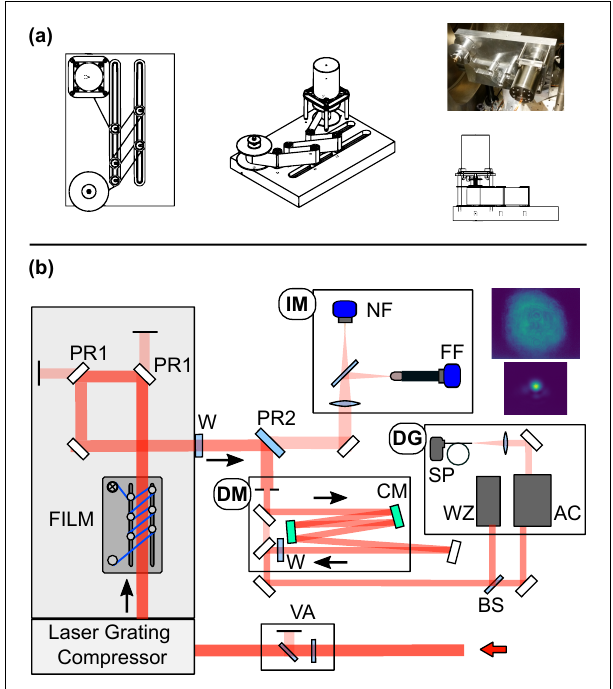
Figure 2. Perspective views and in situ photograph of the FRM prototype are shown in ( a ). The layout of the experiment as described in the text is pictured in ( b